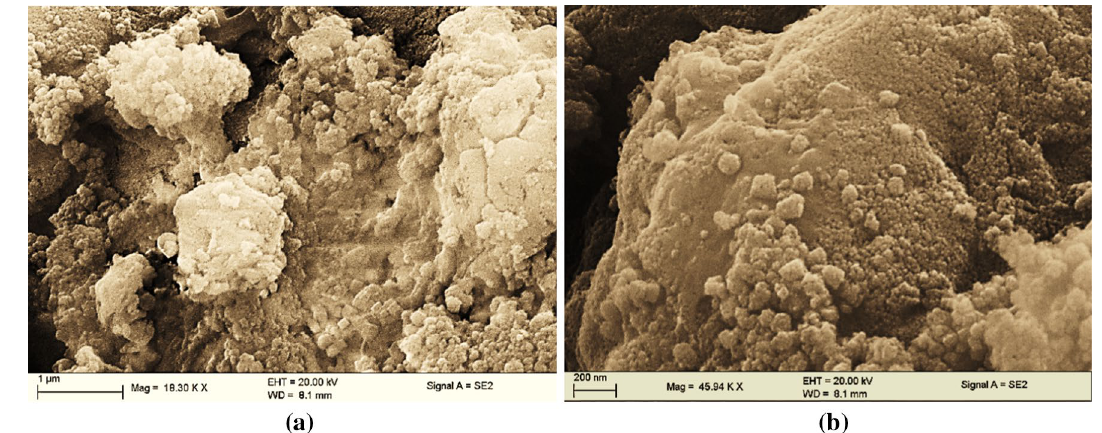
Fig. 11 a Magnified view of MO–chitin at 18 KX. b Magnified view of MO–chitin at 45 KX